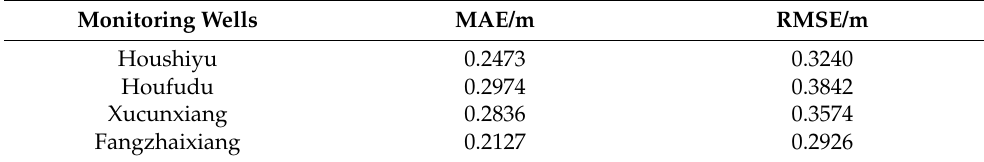
Table 3. Groundwater model simulation error statistics